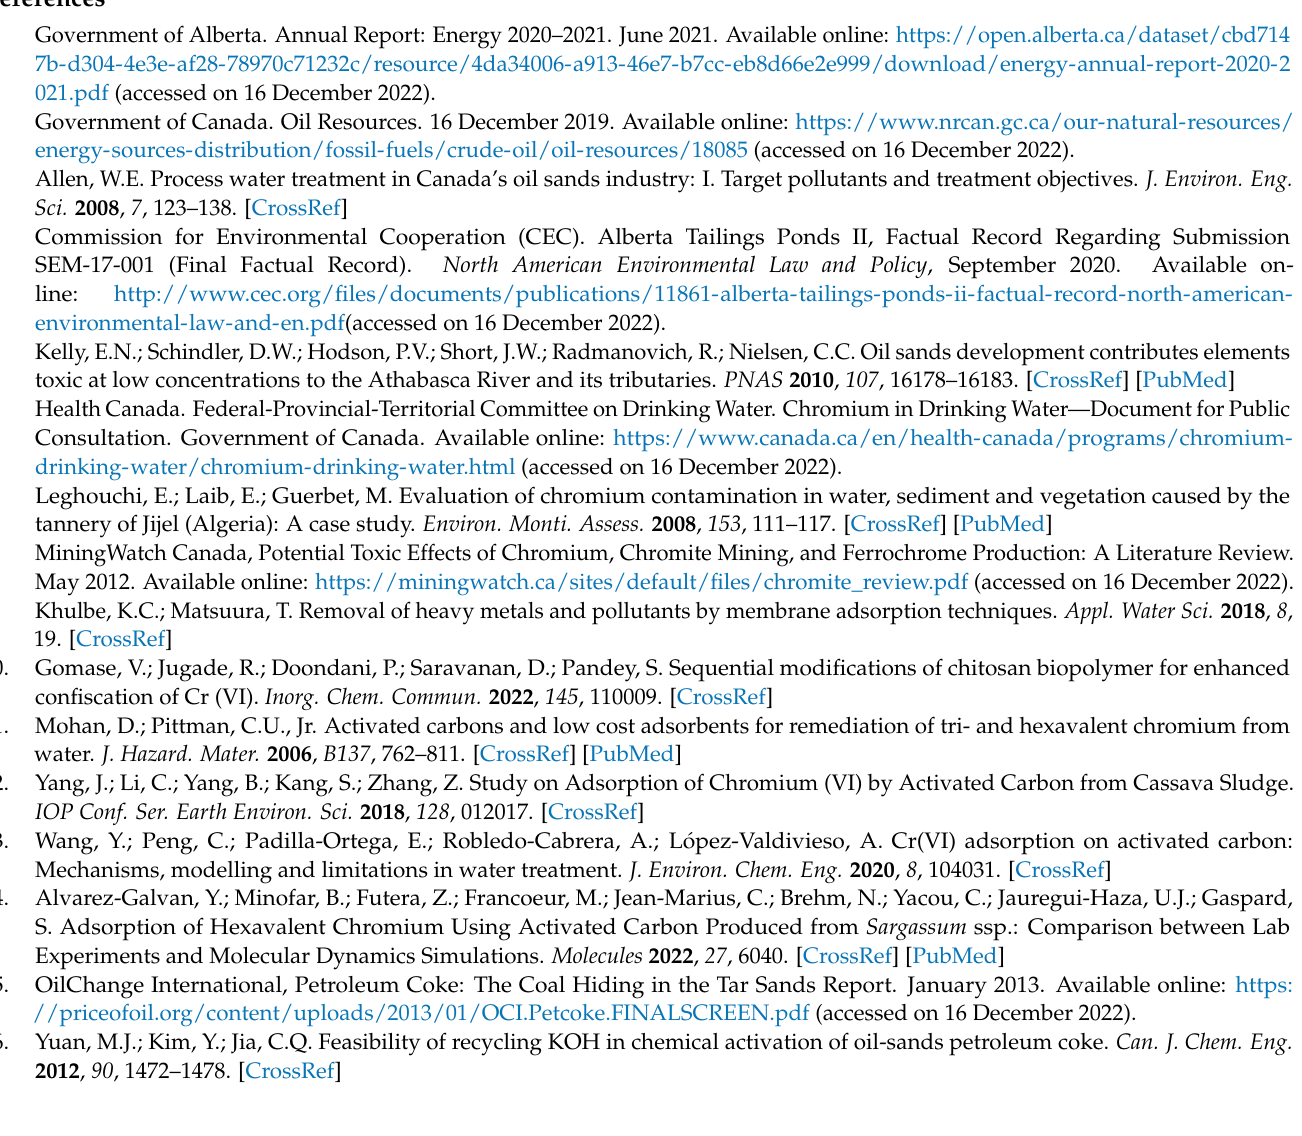
Figure A3. ( Left ) Pseudo-first-order kinetic modeling of thermally-treated activated carbon under Langmuir adsorption kinetics equations. ( Right ) Pseudo-second-order kinetic modeling of thermally-treated activated carbon under Langmuir adsorption kinetics equations.